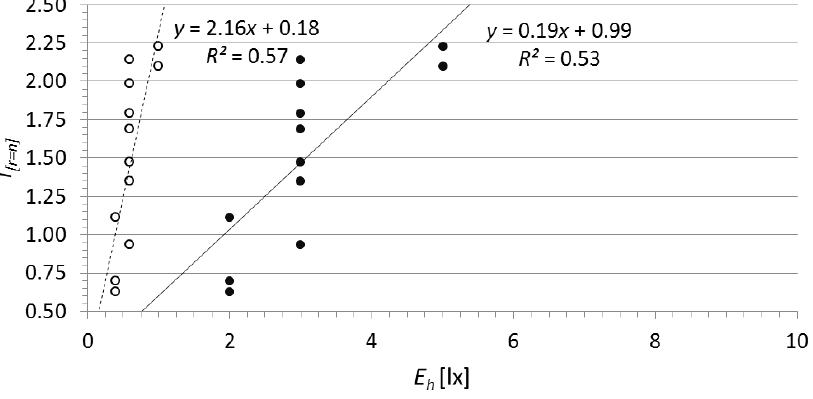
Figure 19. Scenario 3 (ideal case): correlations between I and E h,av,ref (black circles and a continuous line for the regression) and between I and E h,min,ref (white circles and a dotted line for the regression) on the sidewalks on the opposite side of the